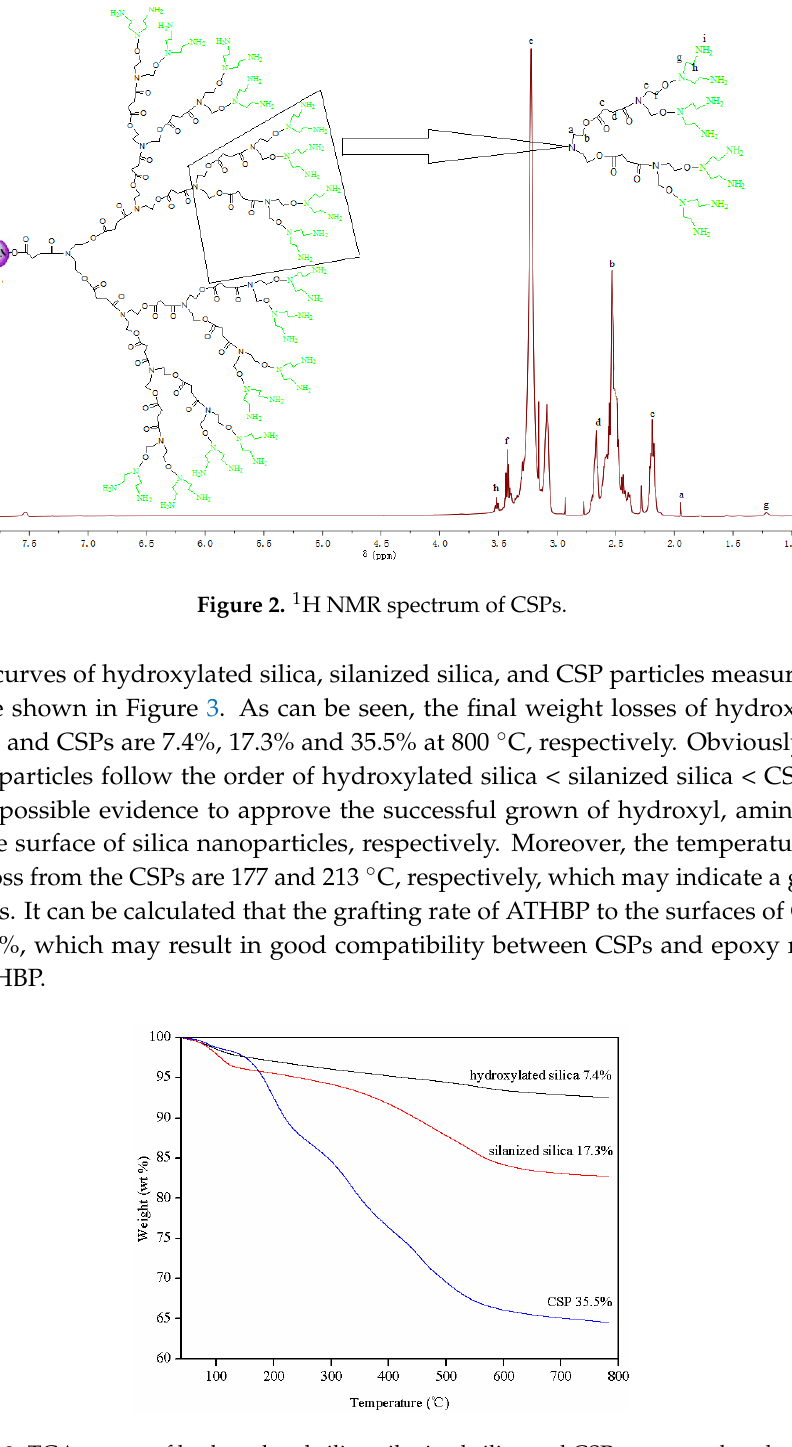
Figure 3 . TGA curves of hydroxylated silica, silanized silica and CSPs measured under N 2 .